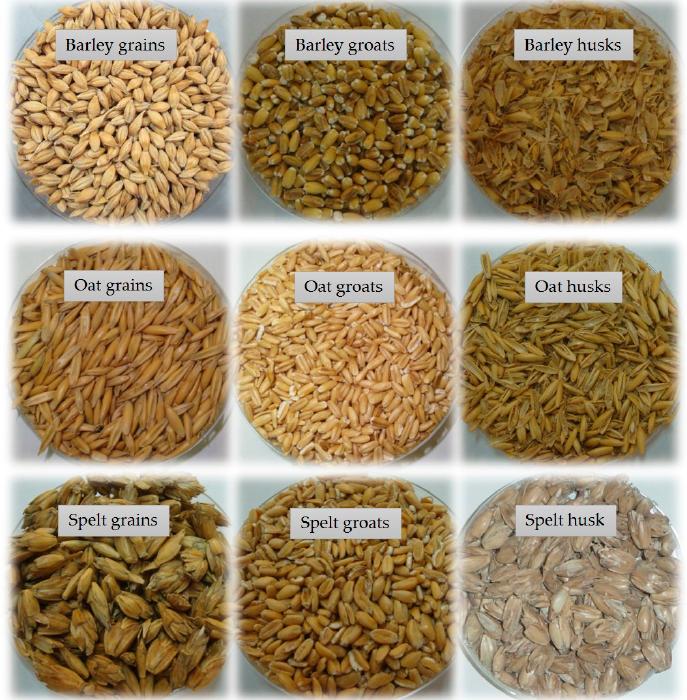
Figure 1. Harvested barley, oat and spelt grains ( left ), minimally processed groats ( centre ) and their husks ( right ).